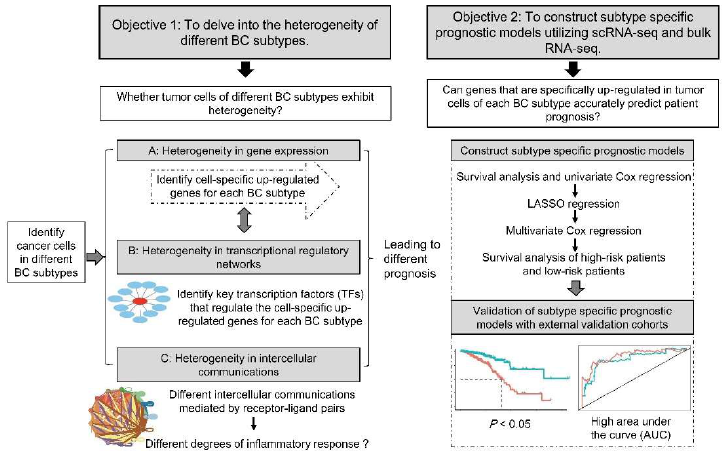
Figure 1. Workflow of delving into the heterogeneity of different breast cancer (BC) subtypes and constructing subtype specific prognostic models. In objective 1, a comparative analysis of three BC subtypes was performed based on the heterogeneity of cancer cells in gene expression, transcrip- tional regulatory networks and cellular communication. In objective 2, survival analysis, univariate Cox, least absolute shrinkage and selection operator (LASSO) regression and multivariate Cox anal- ysis were used to construct subtype specific prognostic models using cancer cell specific upregu- lated genes. The accuracy of the prognostic models was then validated using external validation cohorts. 2. Materials and Methods 2.1. Data Collection and Processing The scRNA-seq data for this study was downloaded from the Gene Expression Om- nibus (GEO) database (GSE176078), and 15 samples including 5 samples from each sub- type (luminal BC, HER2+ BC and TNBC) with similar age and high cell numbers were selected (Table S1). Three broad BC subtypes are distinguished by the expression of ER, PR and HER2: luminal BC (ER+, PR+/−), HER2+ BC (HER2+, ER+/−, PR+/−) and TNBC (ER−, PR−).The breast cancer gene expression profiles and corresponding clinical infor- mation for the training cohort were obtained from The Cancer Genome Atlas (TCGA) da- tabase (https://cancergenome.nih.gov/) on 29 December 2021, containing 678 luminal BC patients, 159 HER2+ BC patients, and 116 TNBC patients after excluding patients with incomplete clinic pathological data. The validation cohort for the subtype of HER2+ BC was derived from the METABRIC dataset (http://www.cbioportal.org/) on 6 March 2022, including 220 HER2+ BC patients. The validation cohort for subtypes of luminal BC and TNBC were downloaded from the GEO database (GSE25066) containing 143 and 122 pa- tients, respectively. All BC patients in the validation cohort have complete survival infor- mation. 2.2. Single-Cell Data Integration and Analysis The Seurat package (version 4) was used to integrate scRNA-seq. Cells with the num- ber of expressing genes below 200 or above 8000 were removed. In addition, cells with mitochondrial content greater than 20% were filtered out, and a total of 73,866 cells with single-cell transcriptome data were obtained for further analysis. The Harmony algorithm was used to eliminate batch effects. The top 2000 feature variables with the highest vari-